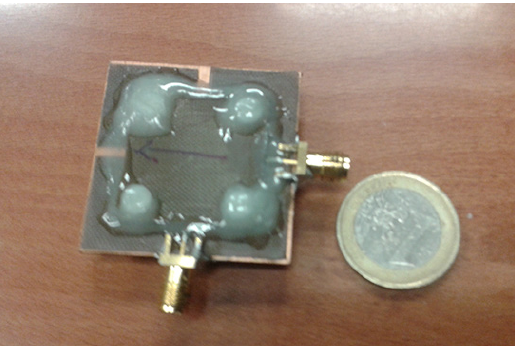
Figure 4. Manufactured LC bandpass